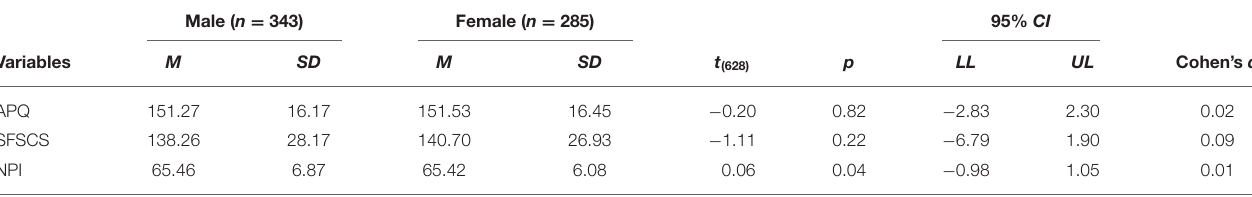
TABLE 4 | Gender differences on parenting, self-concept, and narcissism ( N = 628). Male ( n = 343) Female ( n = 285)